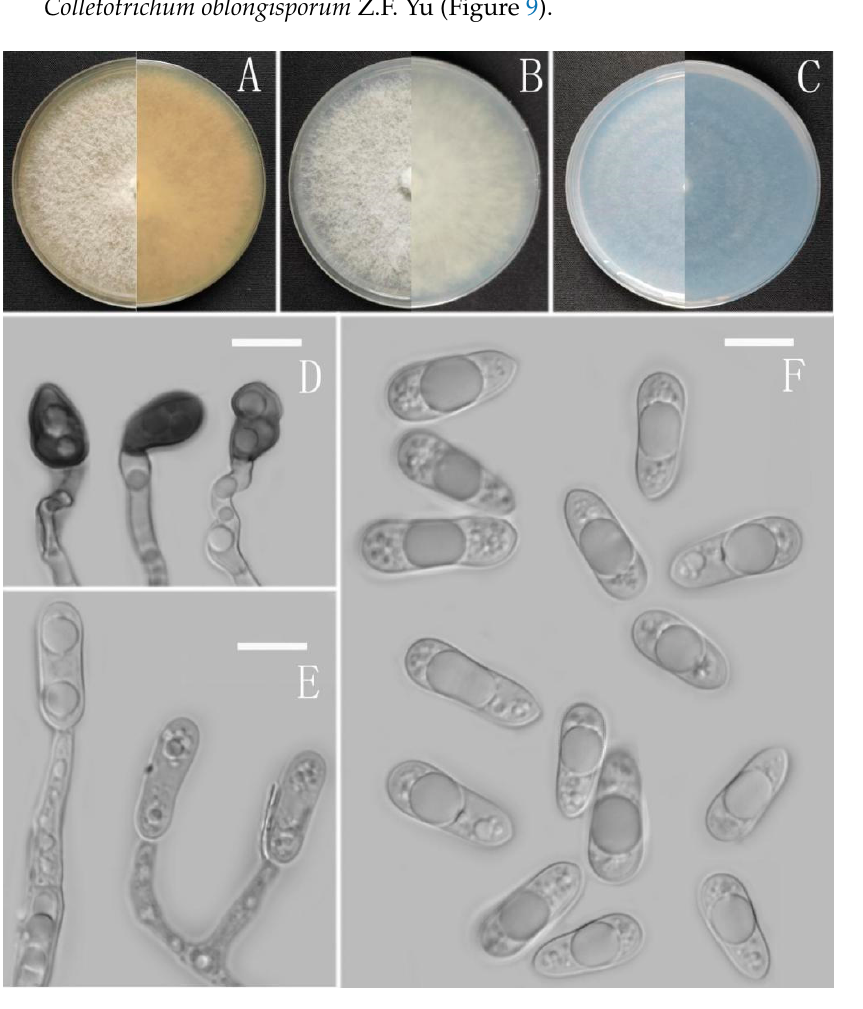
Figure 9. Colletotrichum oblongisporum (YMF 1.06938). ( A – C ) Colonies on media above and below after 7 days at 25 °C (( A) MEA; ( B) PDA; ( C) SNA). ( D ) Appressoria. ( E ) Conidiophores. ( F ) Conidia. Scale bars: ( D – F ) = 10 μ m.